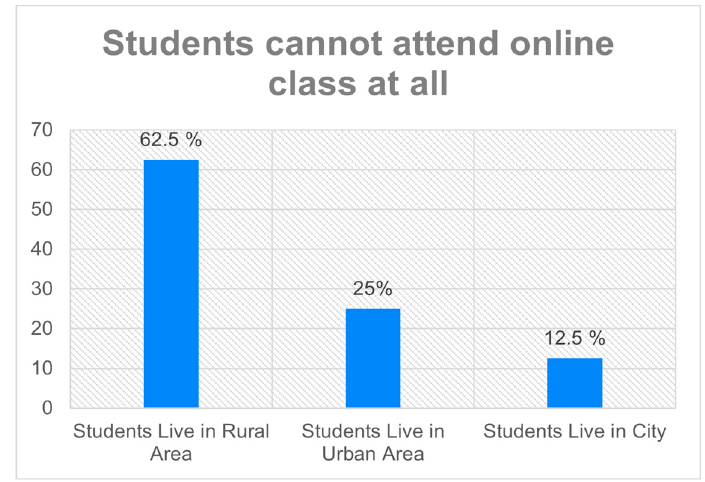
Figure 4. Distribution of students who cannot join any online learning activities based on location.